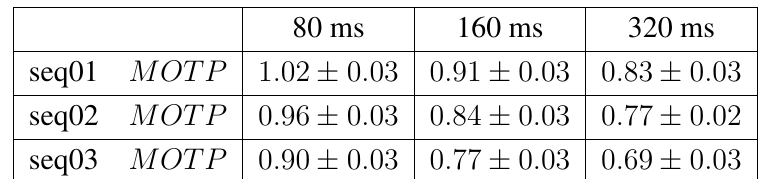
Table 2. Baseline MOT P ( m ) results for all sequences, different frame sizes and microphone setup A.